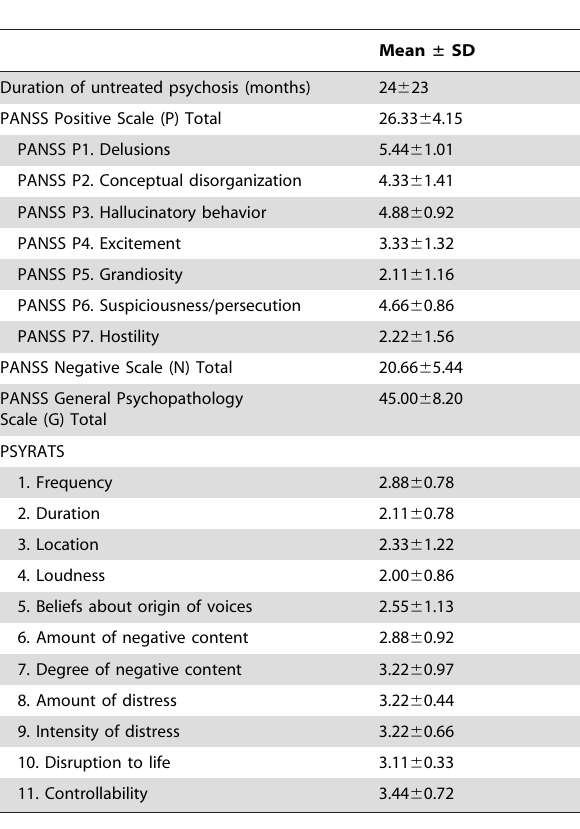
Table 1. Clinical characteristics of AVH patients during the acute psychotic episode (n=9).